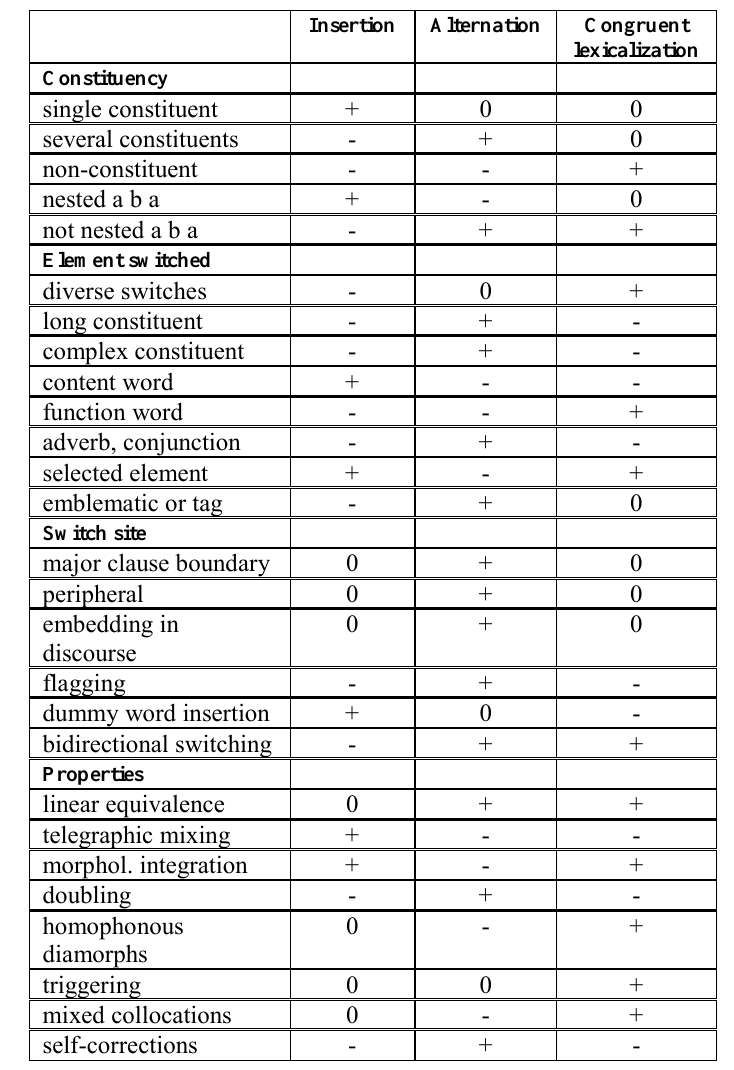
Table 3: Code-switching types, from Muysken (2000: